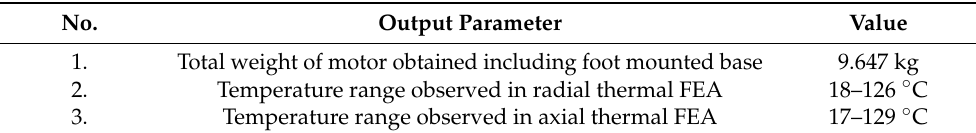
Table 15. Results of thermal analysis of water-cooled electric motor of lightweight PA6GF30 casing. No.